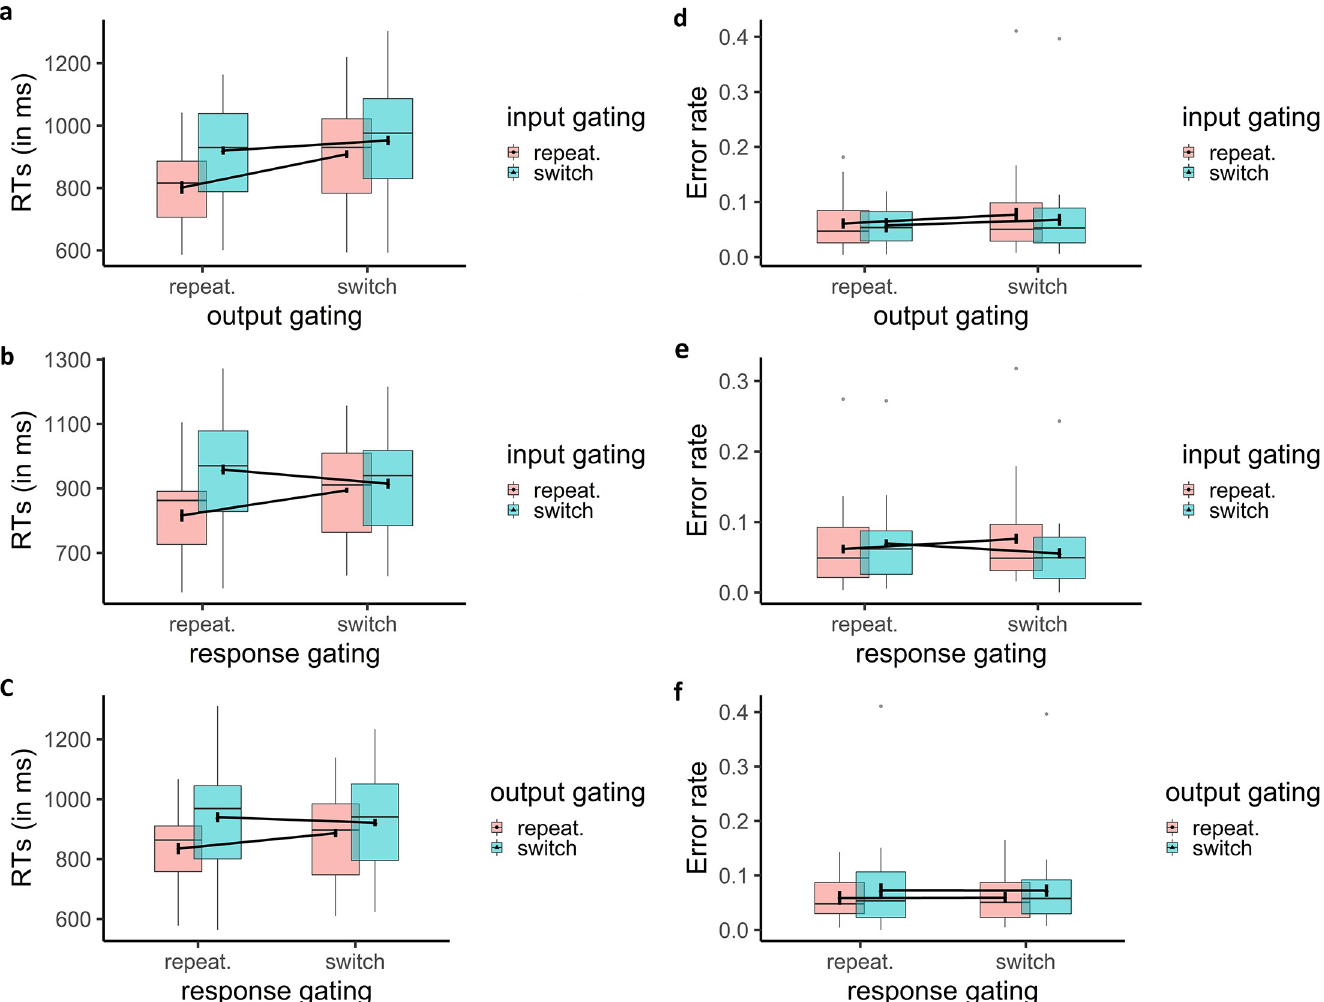
Fig 3. Behavioral effects of switching in gating demands. Mean RT (a-c) and error rate (d-f) demonstrate under-additive interactions at all levels (output and response, input and response and, input and output).